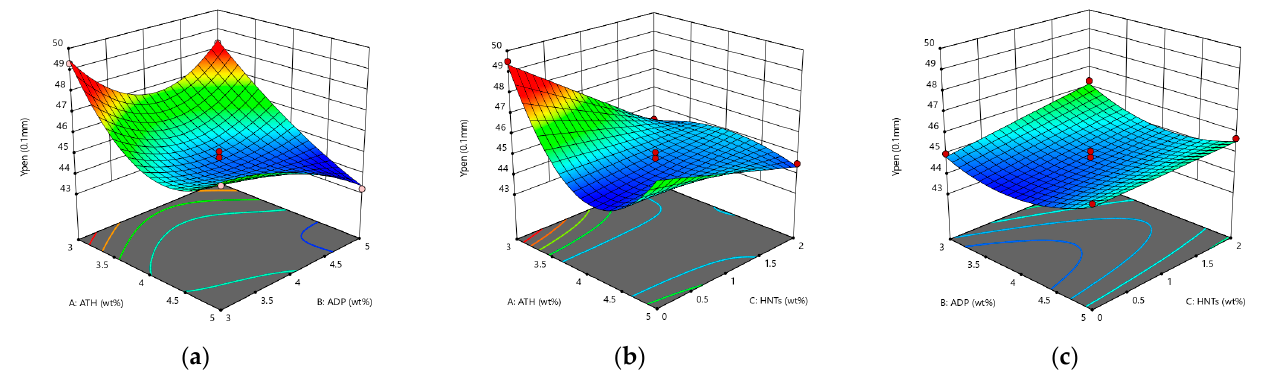
Figure 1. The response surface diagram of the flame retardant system to the change of penetration model: ( a ) Interactive effects of ATH and ADP; ( b ) Interactive effects of ATH and HNTs; and ( c ) Interactive effects of ADP and HNTs.